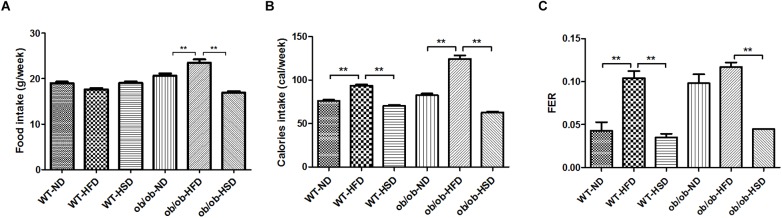
Food and calorie intake and food efficiency ratio. Food intakes were recorded twice per week (A), the calorie intakes were calculated according to the percentage of calories in each diet (B), and the food efficiency ratio (FER) was calculated by dividing body weight gain (g/day) by food intake (g/day) (C). Data were expressed as the means ± SEM and statistically evaluated using one-way ANOVA followed by Bonferroni’s post hoc test. ∗∗P < 0.01 (n = 7).